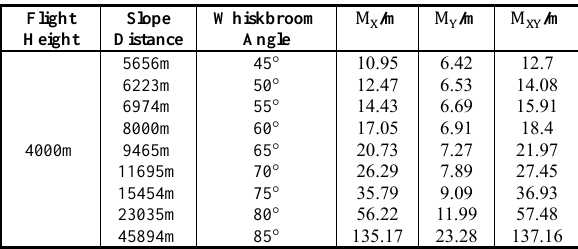
Table 3. The Positioning MSE of Different Flight Heights and Whiskbroom Angles.